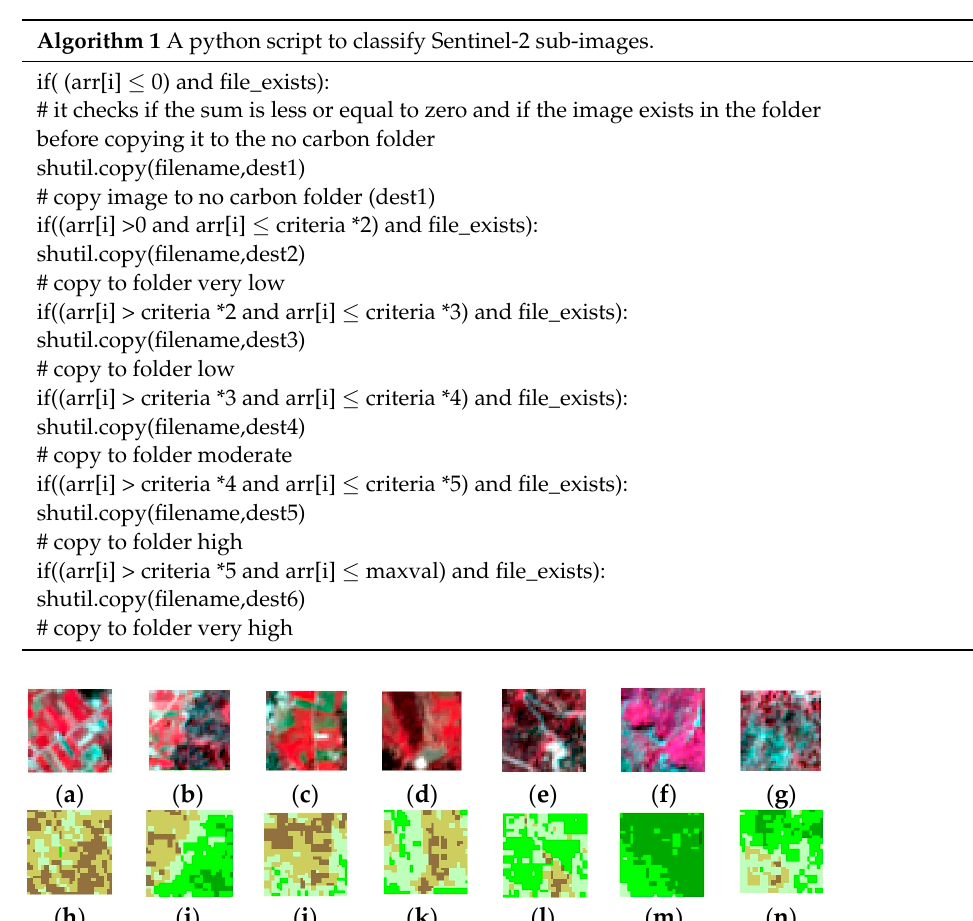
( j ) Figure 10. Loss and accuracy of sub-images of size 32 × 32 processed by ( a , f ) FlexibleNet, ( b , g ) Res- Net50, ( c , h ) EfficientNetB5, ( d , i ) MobileNetV3-Large, and ( e , j ) Xception. Table 4. Summary of the outcomes of the experiments using an image resolution of 32 × 32. Model Name Number of Parameters (Millions)